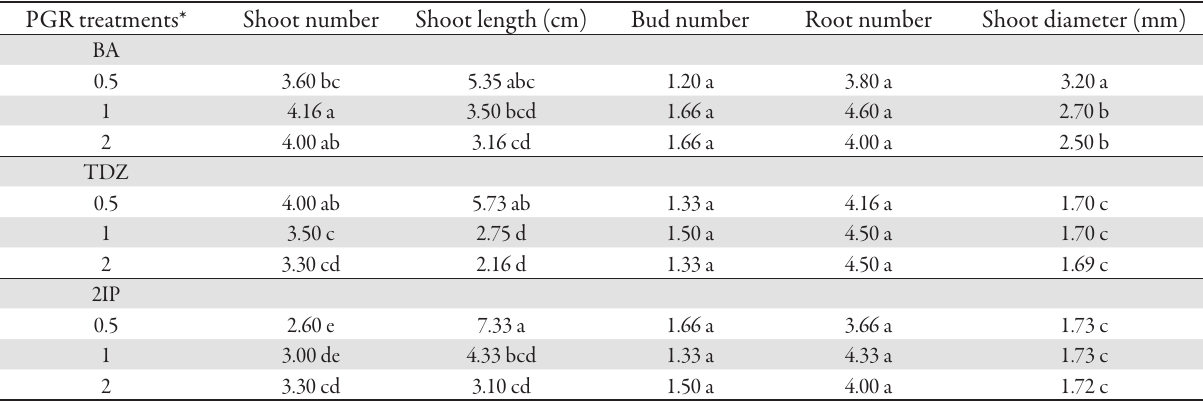
Tab. 1. Effects of the three cytokinins on shoot number, shoot height, bud number, root number, and shoot diameter (regenerated from rhizome-tip derived explants of Alstroemeria ) PGR treatments* Shoot number Shoot length